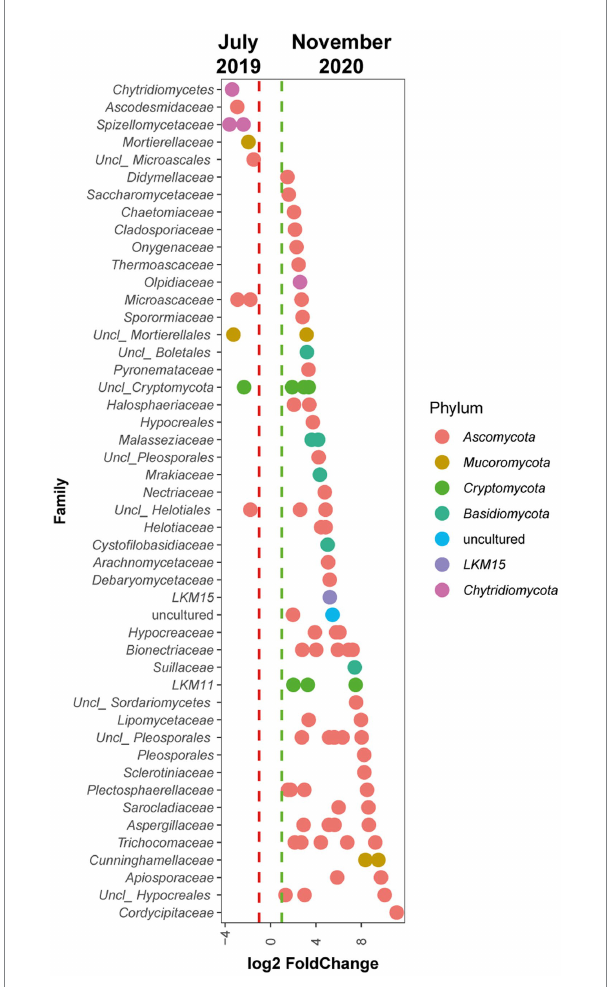
FIGURE 8 Differential abundance analysis of fungal ASVs. The analysis shows the log2Fold Change of individual ASVs from the different fungal families that significantly changed comparing July 2019 and November 2020 sampling times ( p adjusted value